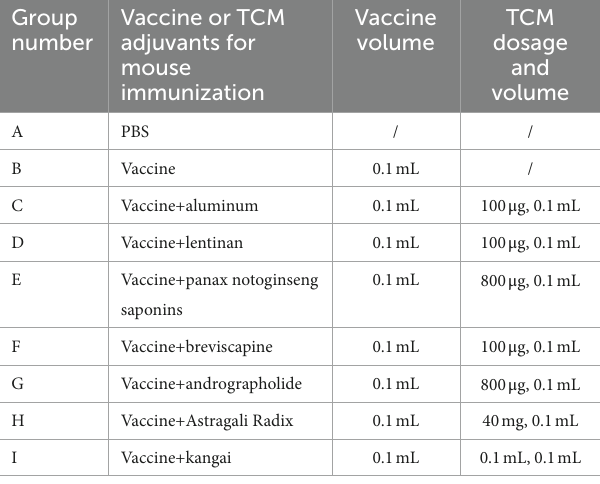
TABLE 1 Animal grouping and vaccination